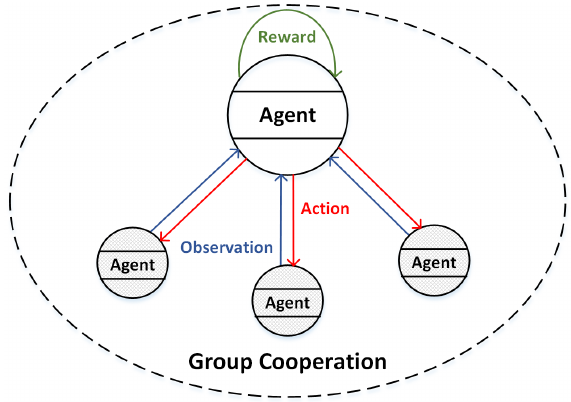
Figure 4. Example of group